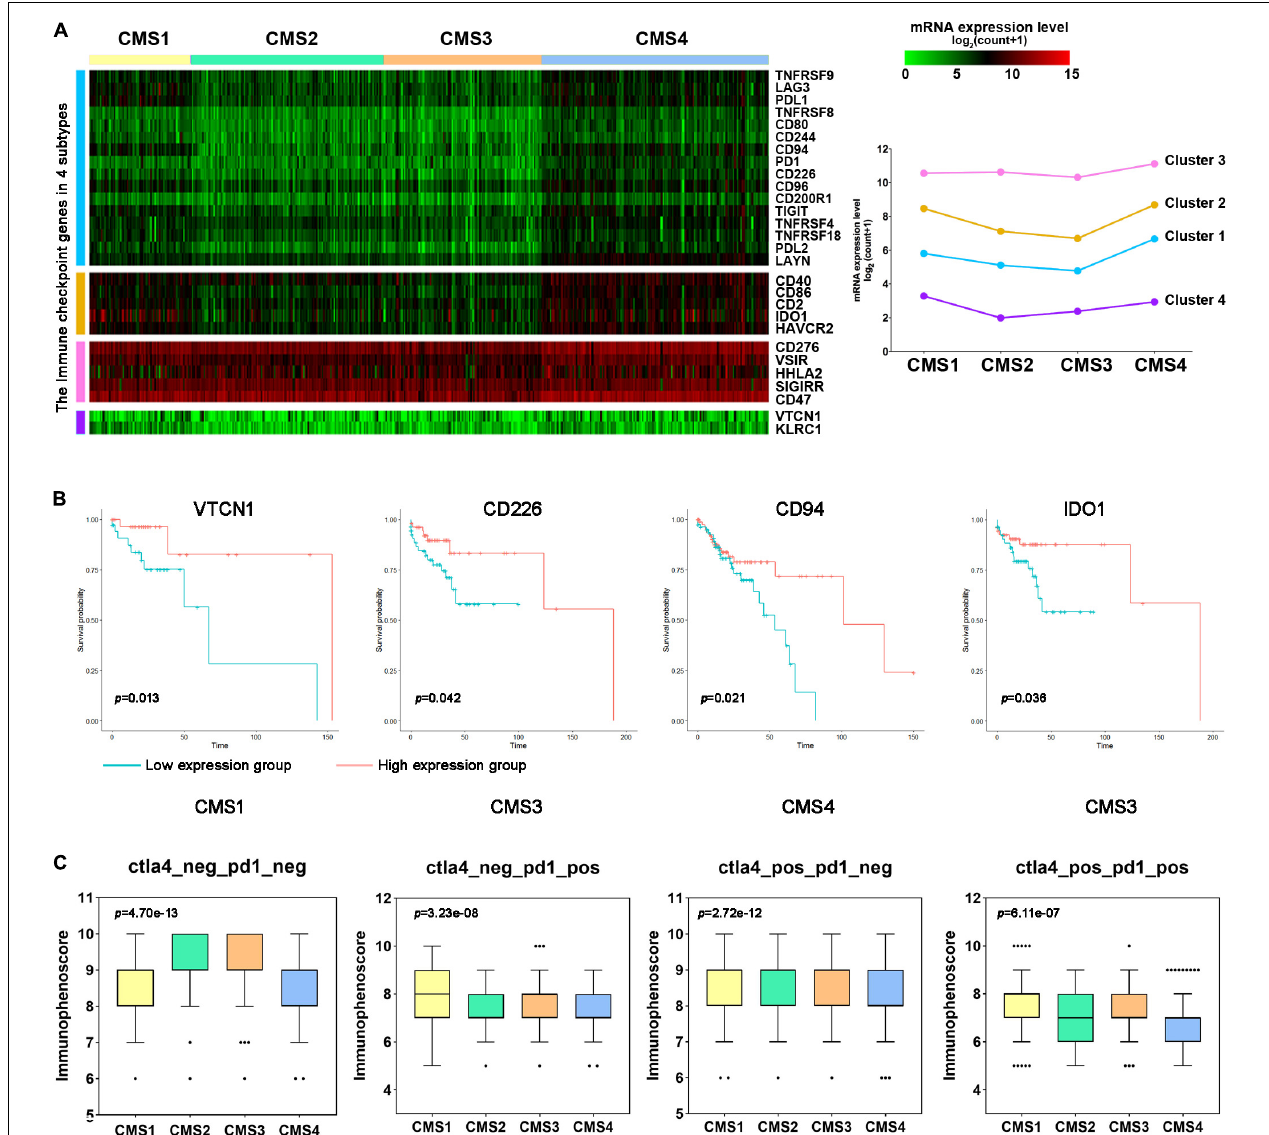
FIGURE 8 | Immune checkpoint gene expression and immune response prediction in each subtype of colon cancer. (A) Hierarchical clustering analysis of the mRNA expression levels for immune inhibitory checkpoint-related genes. (B) Kaplan–Meier survival curves of immune checkpoint genes (ICGs) in patients with different colon cancer subtypes. Red represents the high expression group, and blue represents the low expression group. (C) Comparison of the IPS between patients with each subtype of colon cancer in the CTLA4-negative/positive or PD-1-negative/positive groups. CTLA4 positivity or PD1 positivity represents anti-CTLA4 or anti-PD-1/PD-L1 therapy,